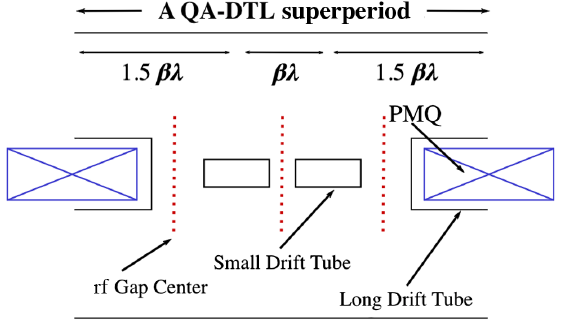
FIG. 3. A schematic illustration of the QA-DTL superperiod inside a tank (horizontal plane view). It comprises two half-length long drift tubes with PMQ and two small drift tubes without.